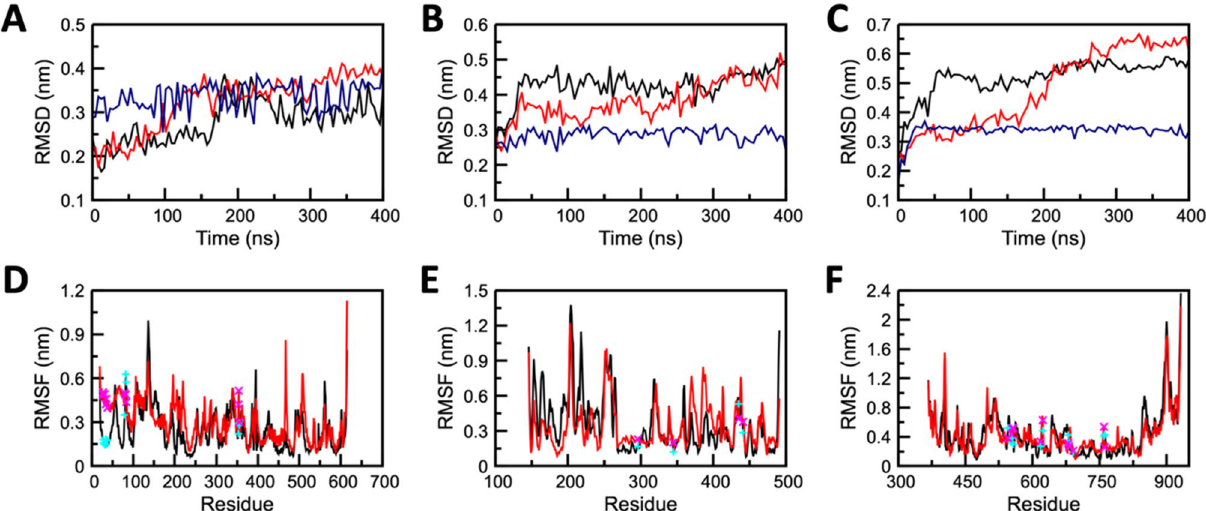
Figure 2. Conformational stability of apo and complex forms of ( A , D ) ACE2 ( B , E ) TMPRSS2, and ( C , F ) RdRP protein. ( A , B , C ) Backbone-RMSD for protein and all-atom RMSD for Grazoprevir and ( C , D , E ) Residual RMSF. Profile of apo, complex structures, and Grazoprevir are displayed in red, black, and blue curves , respectively. Locations of key residues are shown by cyan and magenta color symbols for complex and apo states